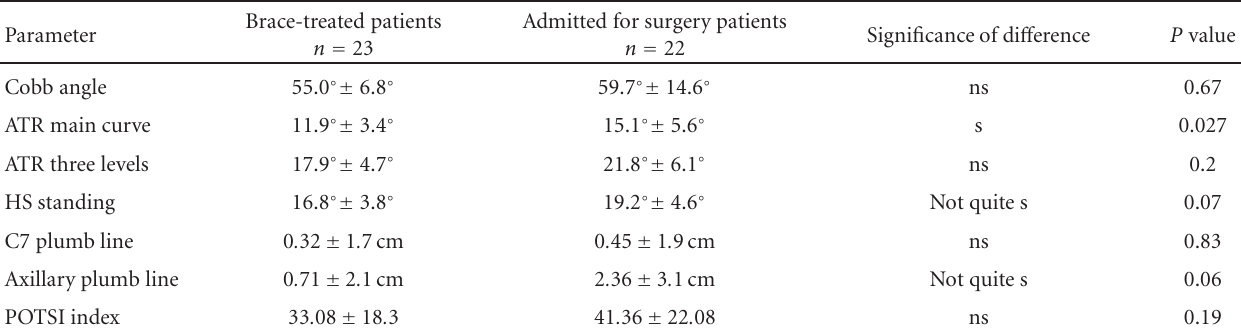
Table 2: Values of the clinical parameters in braced patients versus admitted for surgical treatment patients matched for sex, age, and Cobb angle. The mean and standard deviation are presented. HS: Hump Sum. s: di ff erence significant. ns: di ff erence not significant.